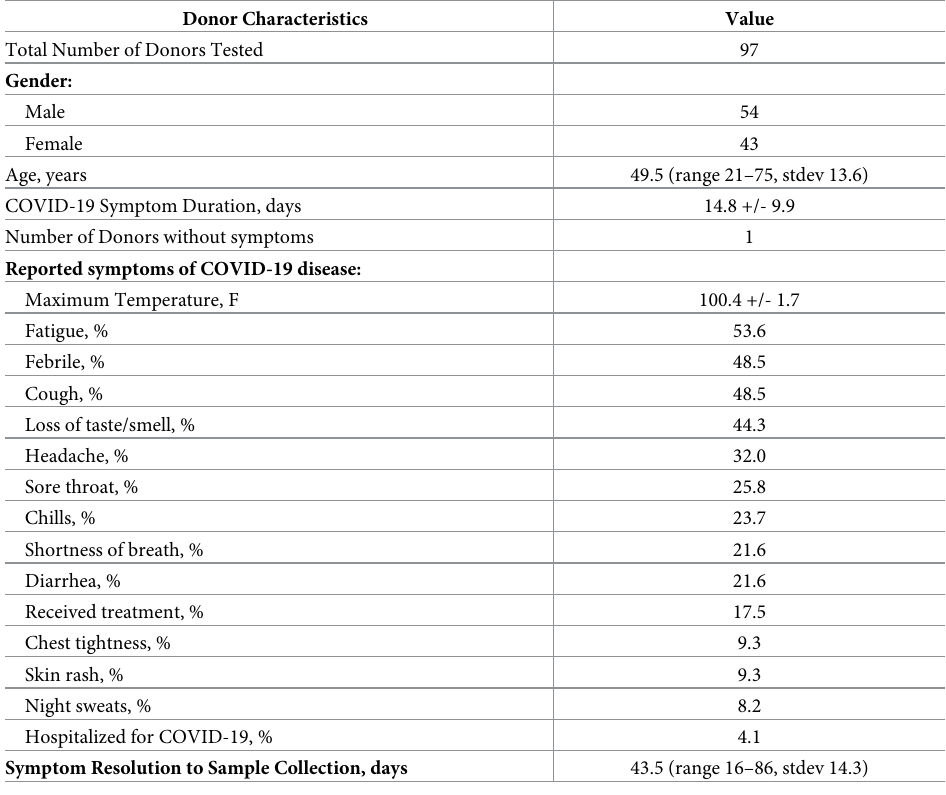
Table 1. COVID-19 convalescent plasma donor